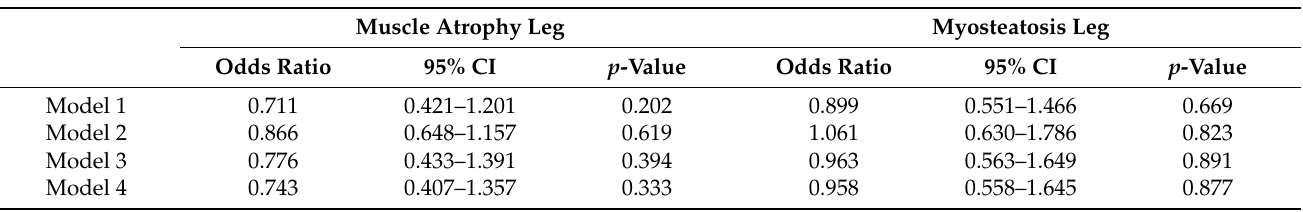
Model 1 = Muscle atrophy or myosteatosis on reintervention. Model 2 = Muscle atrophy or myosteatosis on reintervention controlled for patient-related factors (i.e., age, BMI, and smoking status). Model 3 = Muscle atrophy or myosteatosis on reintervention controlled for both patient-related and disease-related factors (i.e., type of intervention and Fontaine class). Model 4 = Muscle atrophy or myosteatosis on reintervention controlled for patient-related, disease-related, and comorbidities-related factors (i.e., hypertension, hypercholesterolemia, coronary artery disease, hemodialysis, and ischemic stroke). CI = Confidence